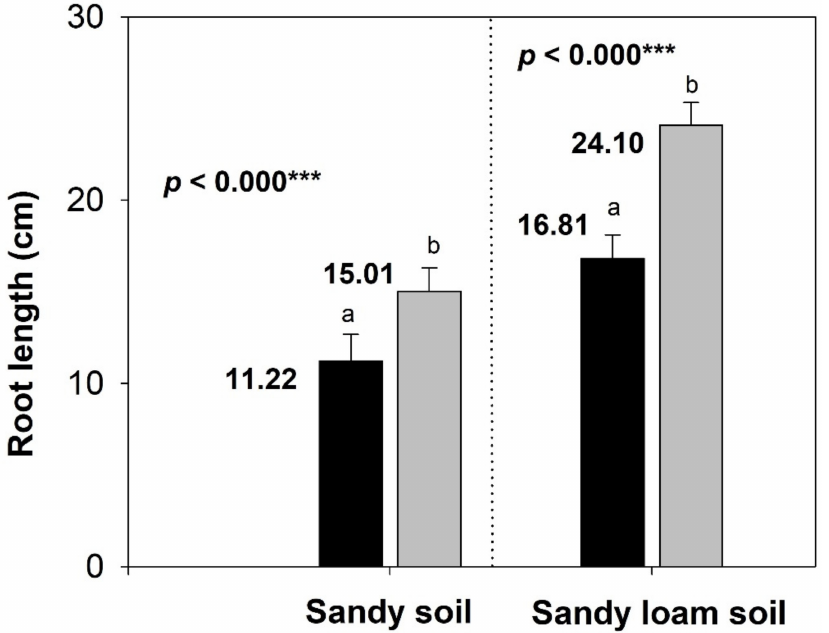
Figure 3. Mean values of root length of turfgrass plants under biostimulant, and control conditions from the two type of Scheme 0. Means followed by different letters are significantly different ( p < 0.05) according to Tukey’s HSD test. Significance levels: *** p < 0.001.